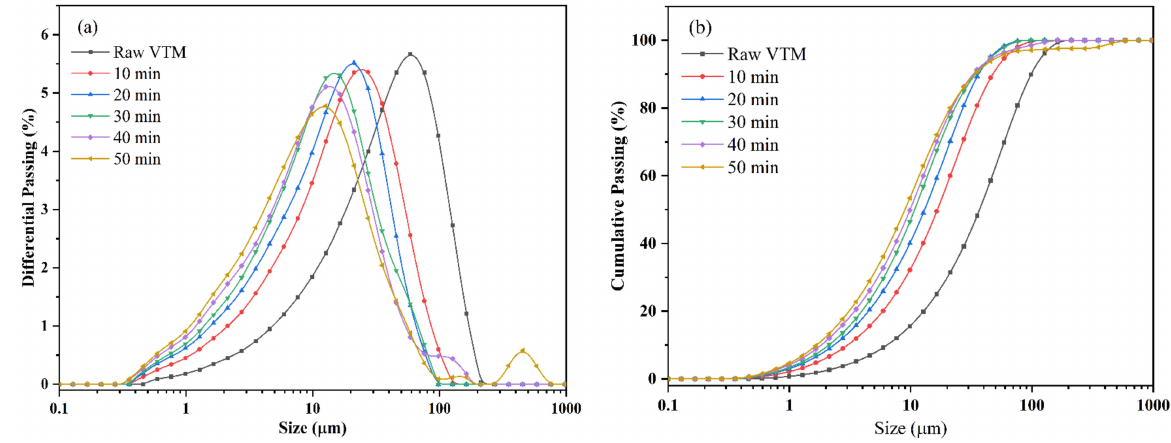
Figure 3. PSD curves of LVTC powder: ( a ) differential curve, ( b ) integral curve.